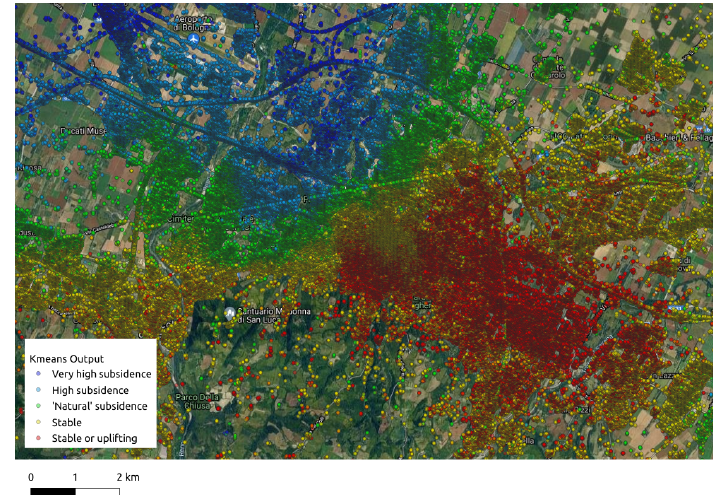
Figure 7. A visual inspection of the k-means clusters obtained with the ascending orbit dataset in the metropolitan area of